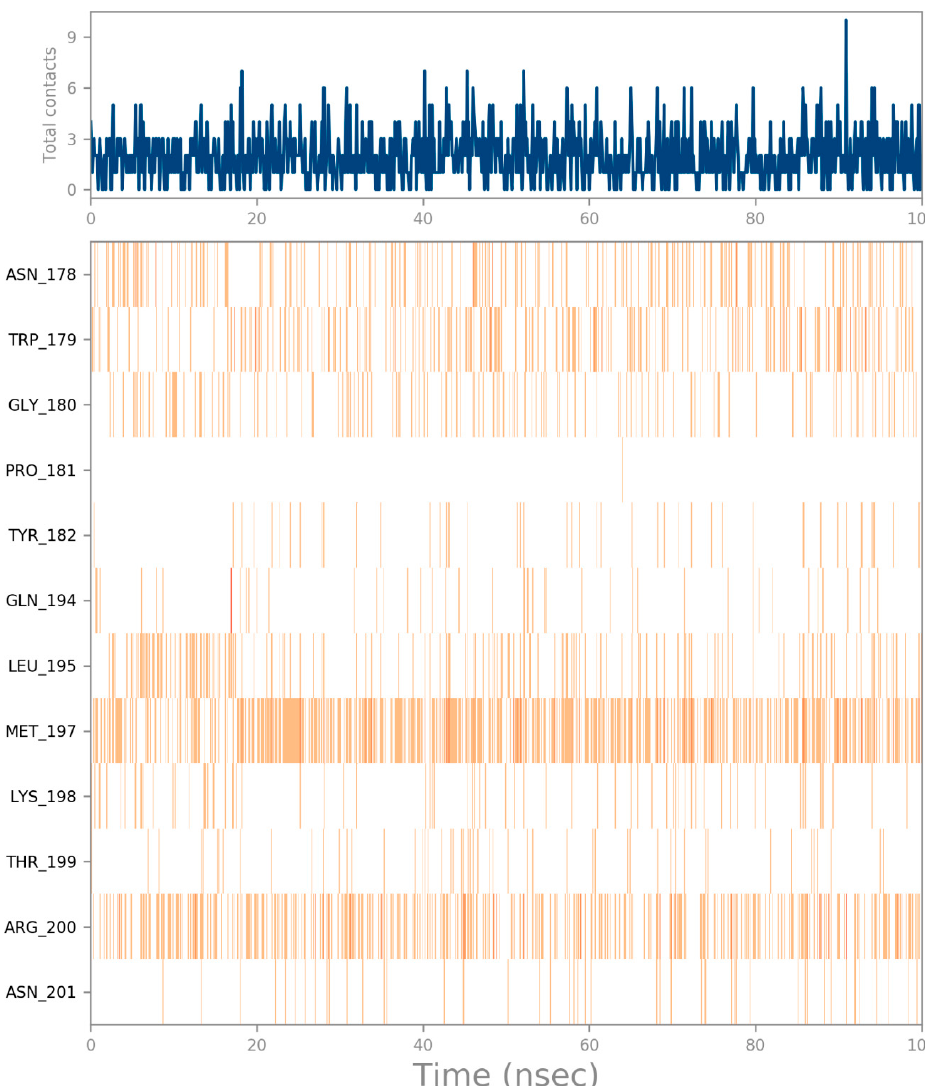
Figure 5. Emodin contacts with amino acids in site 1.